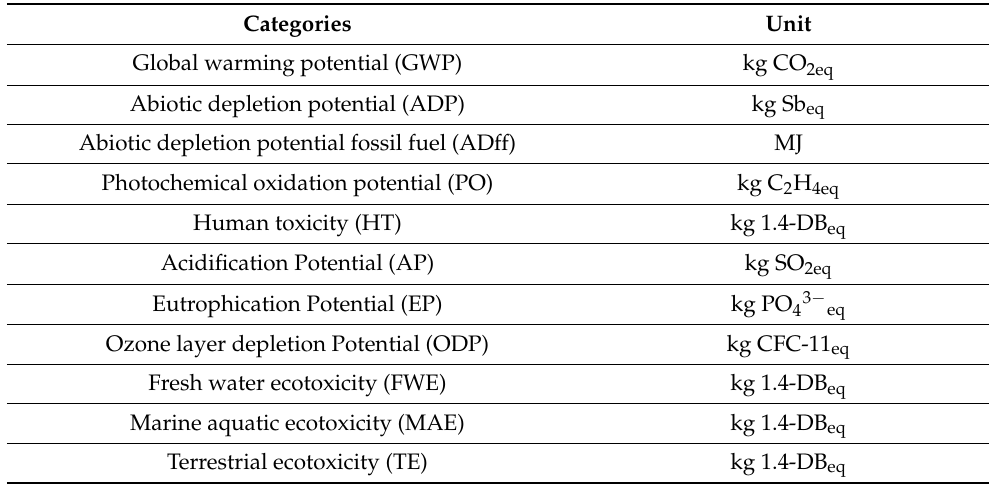
Table 1. CML-IA impact